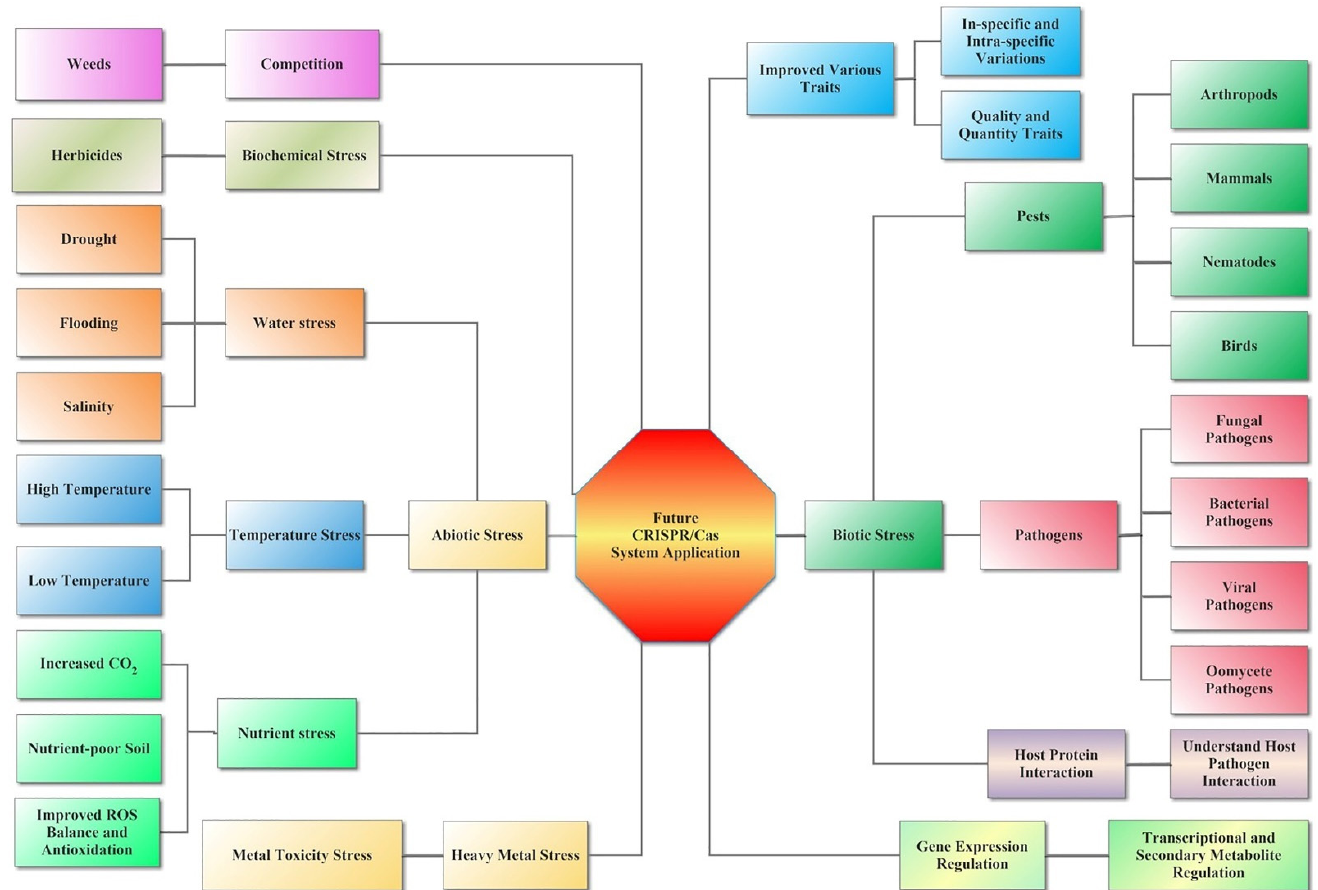
Figure 3. Future applications of CRISPR/Cas in plants against the biotic and abiotic stress. CRISPR/Cas represents the future of genome editing technology and the potential use of the CRISPR/Cas system in various disciplines under biotic and abiotic stresses of agriculture. With the maturity of genome editing (GE) technology and the development of new GE tools, the application of CRISPR/Cas is becoming more and more extensive. CRISPR/Cas can now achieve gene knockout, knock-in, and knock-up in plants, replacing a single base to cause amino acid changes, etc. There- fore, CRISPR/Cas can be used to modify key genes of biotic and abiotic stresses, improving crop growth and development and coping with various environmental stresses to create more germplasm resources that meet human needs. Table 2. CRISPR/Cas induced plant resistance against various diseases.